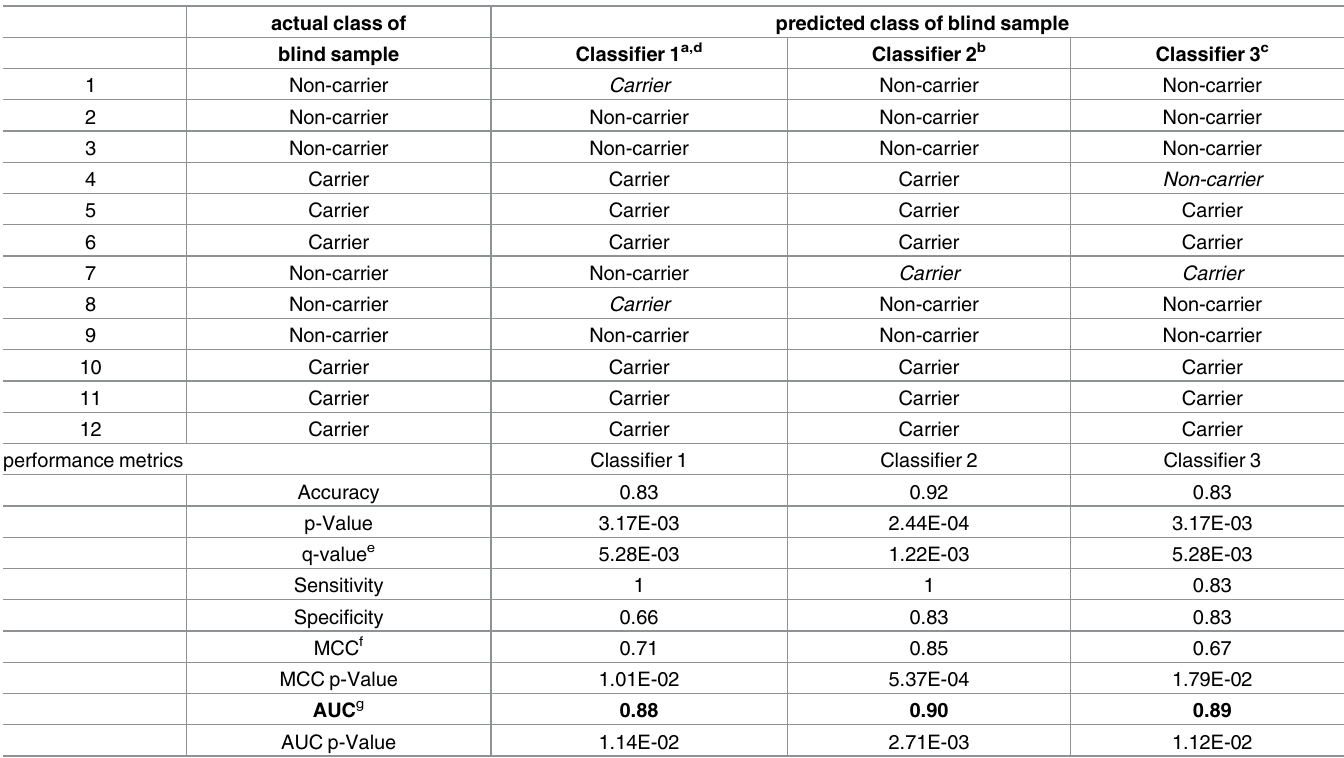
Table 1. Blind accuraciesof ALS classifiers.